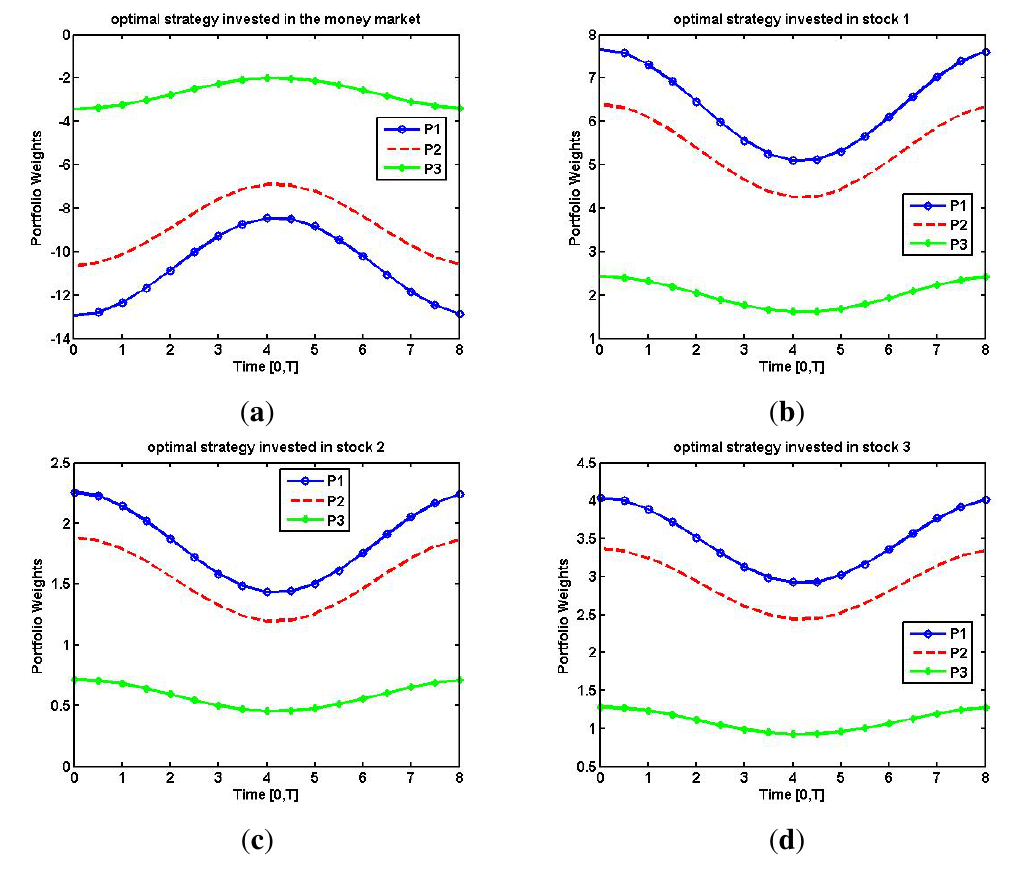
Figure 1. ( a ) Optimal portfolio strategy in the money market (upper left); ( b ) stock 1 (upper right); ( c ) stock 2 (lower left) and ( d ) stock 3 (lower right).